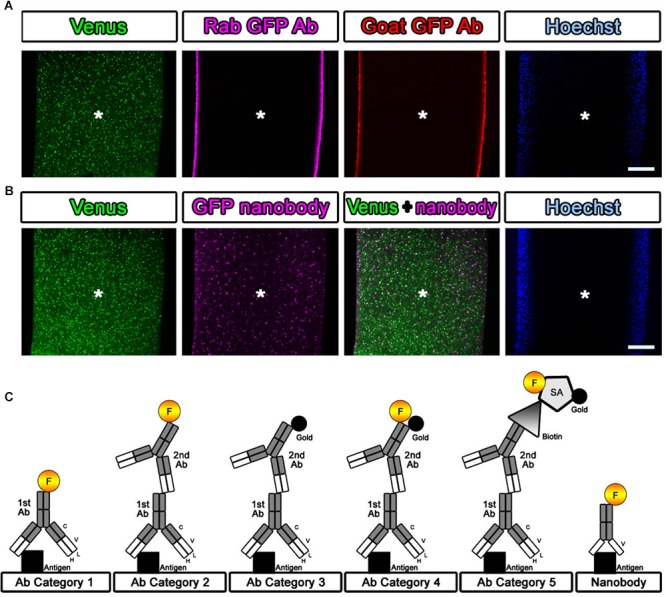
Evaluation of the antibody and nanobody. (A,B) Lack of detergent application completely inhibited the infiltration of the antibody. Antibodies did not penetrate into the center area of the tissue, but the nanobodies partially labeled the GFP prepared without detergent at a depth of several hundred micrometers. Asterisk: center of the brain section. Scale bars: 200 μm. (C) Categorization of antibodies and nanobodies. Fluorescence labeling with antibody was usually performed in one step using a direct fluorescence-conjugated primary antibody (Category 1) or in two steps using a fluorescence-conjugated secondary antibody (Category 2). For EM observation, gold labeling or DAB (3,3′-diaminobenzidine tetrahydrochloride) reaction with HRP (horseradish peroxidase) was required to visualize the antibody localization (Category 3). In this study, fluorescence- and gold-conjugated secondary antibodies were mainly used (Category 4). When an appropriate dual-labeled secondary antibody was not available, the use of biotin-conjugated secondary antibodies and fluorescence- and gold-conjugated streptavidin helped complete the procedure (Category 5).